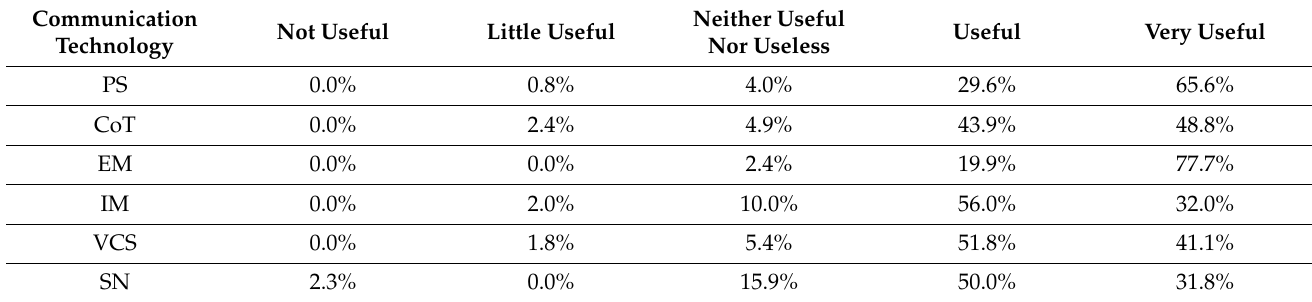
Table 8. Usefulness of the use of communication technologies by teachers.